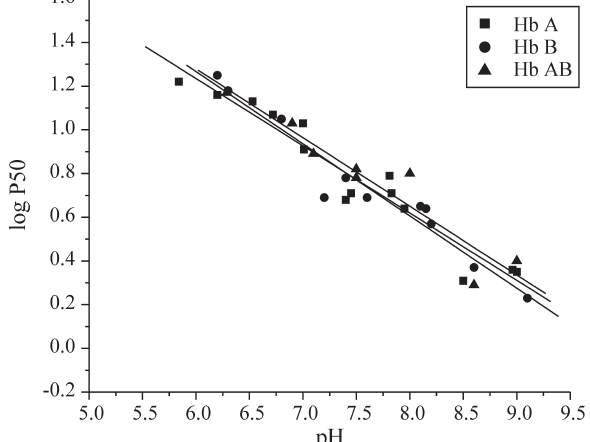
Figure 3 - pH dependence of n values in stripped hemoglobin in the pres- ence of the chloride ion. Buffer Tris-HCl 0.05 M.